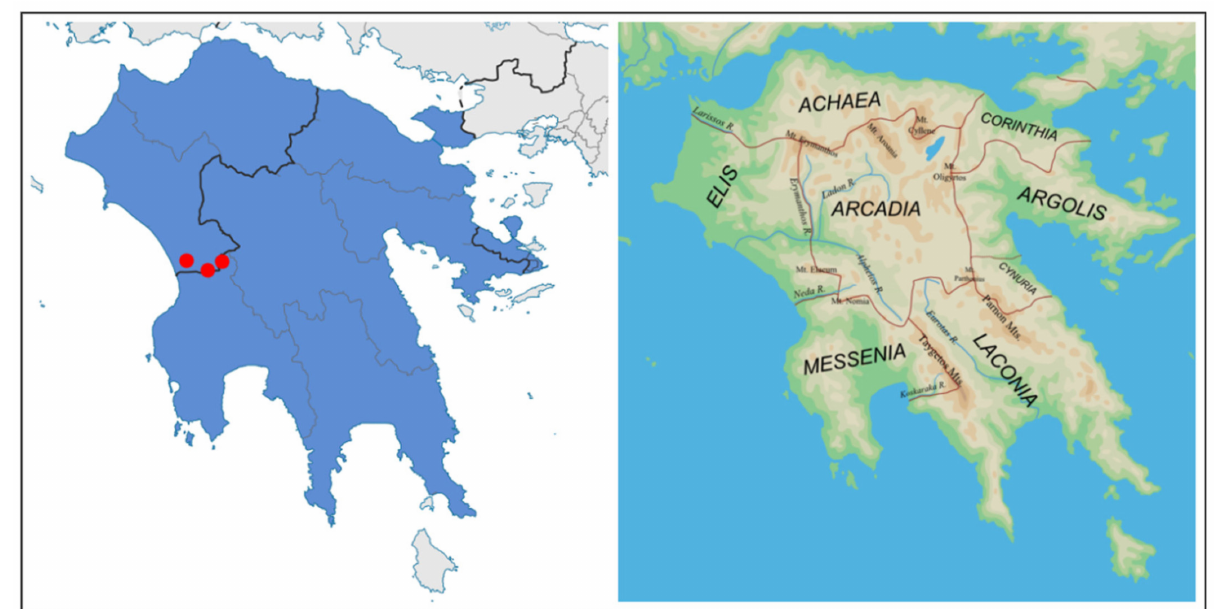
Figure 2. ( Left ): locations of the case studies, (from east to west) the Temple of Apollo Epikourios at Bassae, the Temple of Athena and Zeus Sotiros at Phigalia, and the archaeological site of Lepreum, in a modern administrative map of Peloponnese (adapted from https://commons.wikimedia.org/wiki/File:Location_map_of_Peloponnese_(Greece).svg (accessed on 1 June 2021), used under a CC BY-SA 3.0 Unported license https://creativecommons.org/licenses/by-sa/3.0/deed.en (accessed on 1 June 2021)). ( Right ): the Ancient Regions of Peloponnese (https://commons.wikimedia.org/wiki/File:Ancient_Regions_